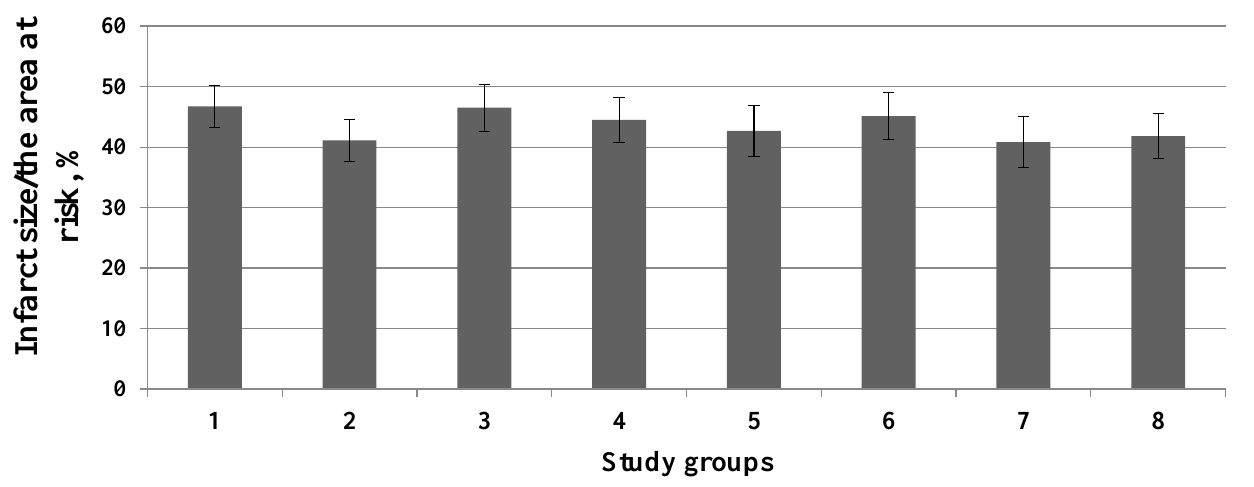
Figure 6. Effect inhibitors of kinases and molecular structures on the infarct size/area at risk ratio ( Y -axis). 1 — Control; 2 — Glibenclamide; 3 — 5-HD; 4 — HMR1098; 5 — Atractyloside; 6 — Paxilline; 7 — MPG; 8 — Tempol. Data represent the means ± SEM. Each study group included 12 rats.